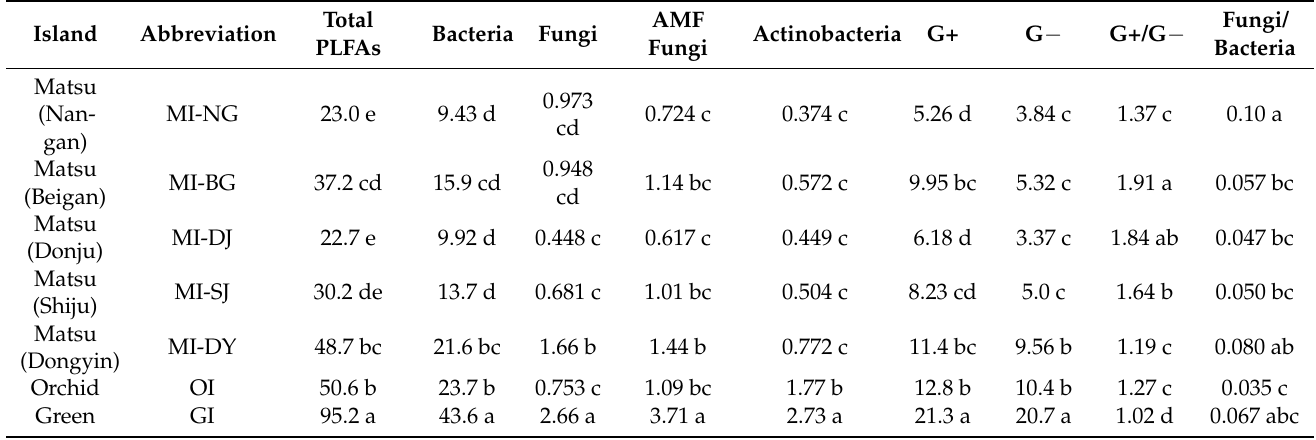
Table 3. Soil biomass content based on phospholipid acid biomarkers (nmol g − 1 soil) and the ratios of the biomarkers of different